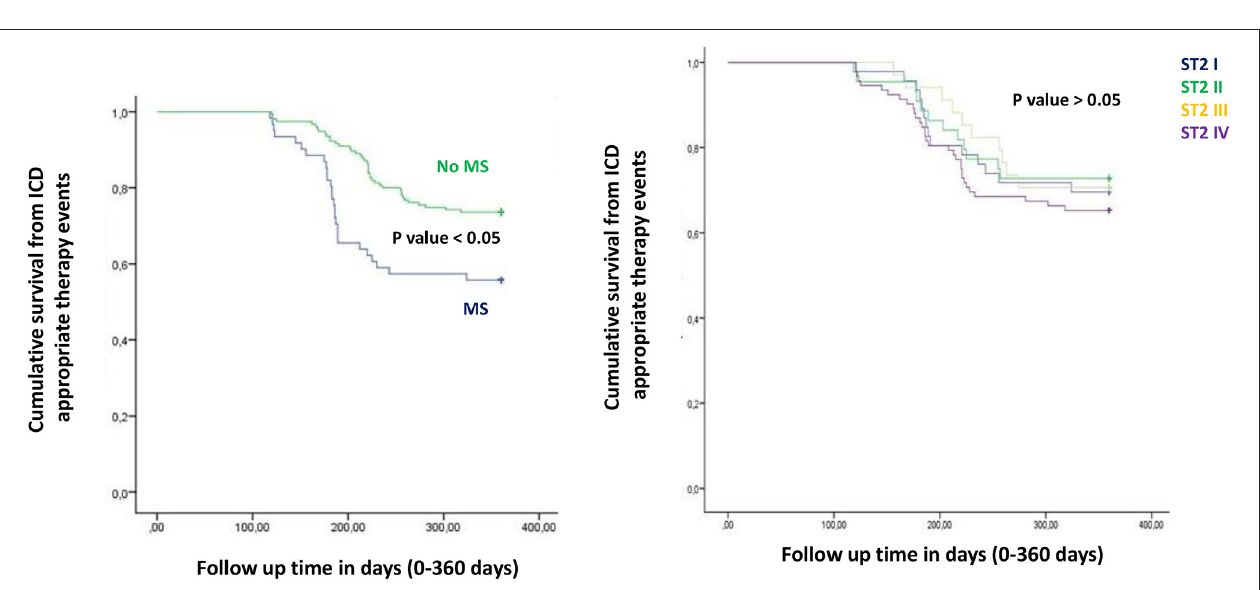
FIGURE 4 | The curve representation of survival after ICD therapy events as “cumulative survival after ICD therapy events” (on y axis) during 360 days follow up (on x axis) comparing MS vs. no MS patients (left part), and different quartiles (right